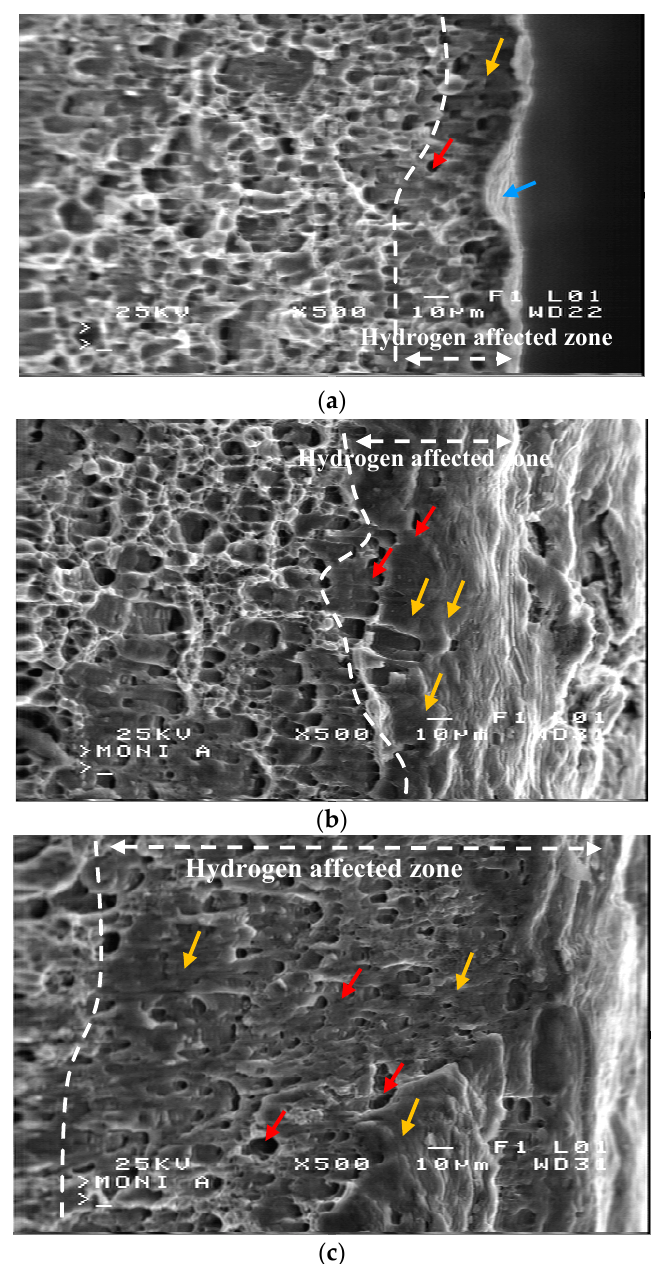
Figure 6. SEM micrograph of the fractured surface of hydrogen charged 5083 aluminum alloy ( a ) without cold rolling deformation; ( b ) with 7% cold rolling deformation; and ( c ) with 15% cold rolling deformation. Charging conditions: 30 mA/cm 2 for 6 h.